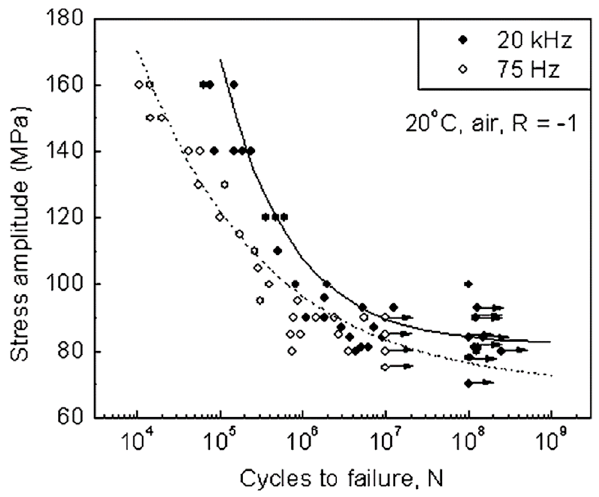
Figure 4. Fatigue data of cast aluminium E319-T7 with servo-hydraulic equipment at 75 Hz and with ultrasonic equipment at 20 kHz; reprinted with permission from Springer Nature [9].